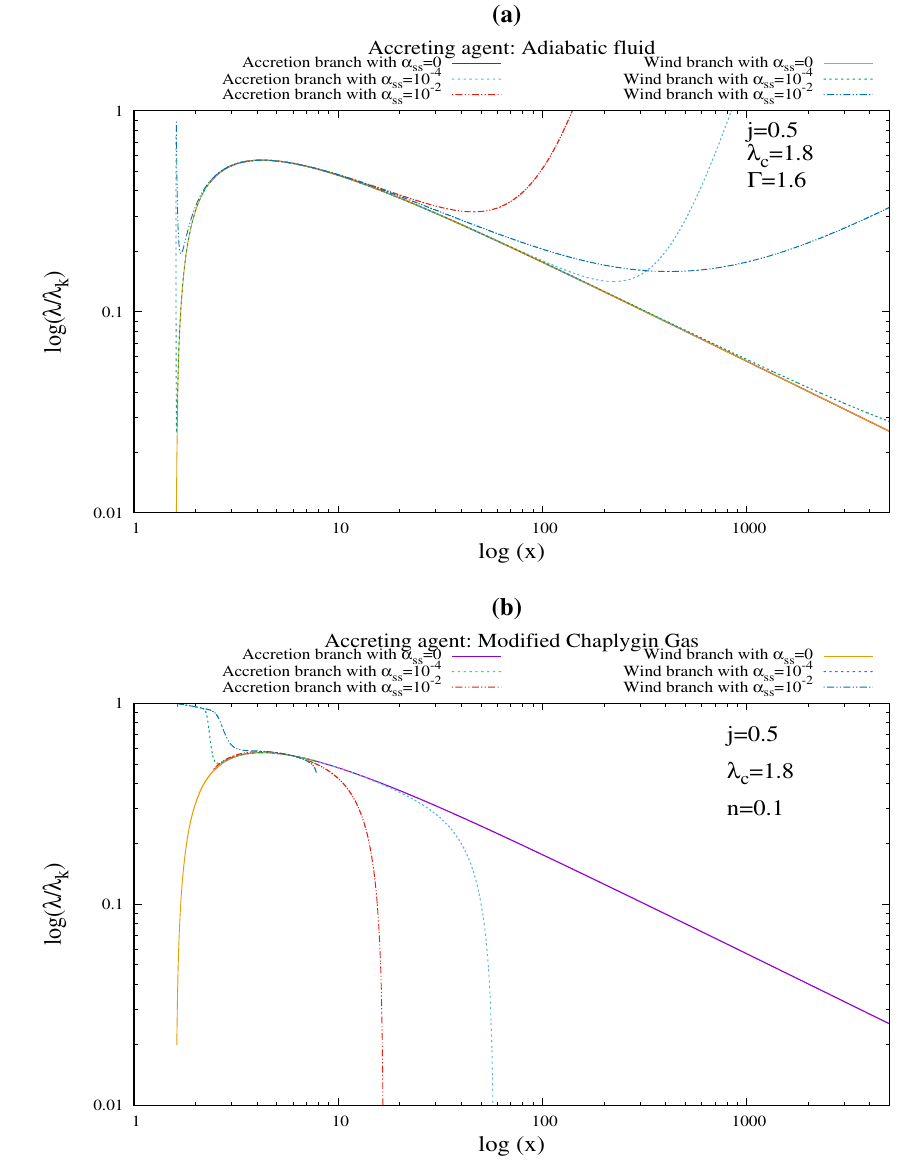
Purple solid, Blue dashed and Red double dot dashed lines are for the accretion. Yellow solid, green dashed and blue double dot dashed lines are for the wind